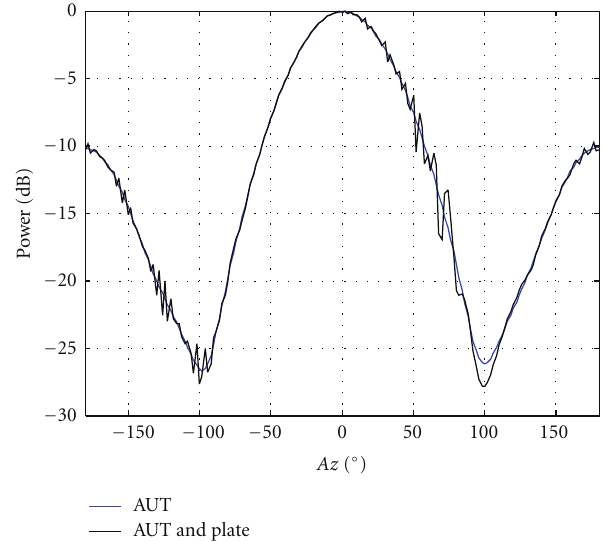
Figure 6: Far-field amplitude pattern of OEWG with and without plate. AUT o ff set = 50cm.